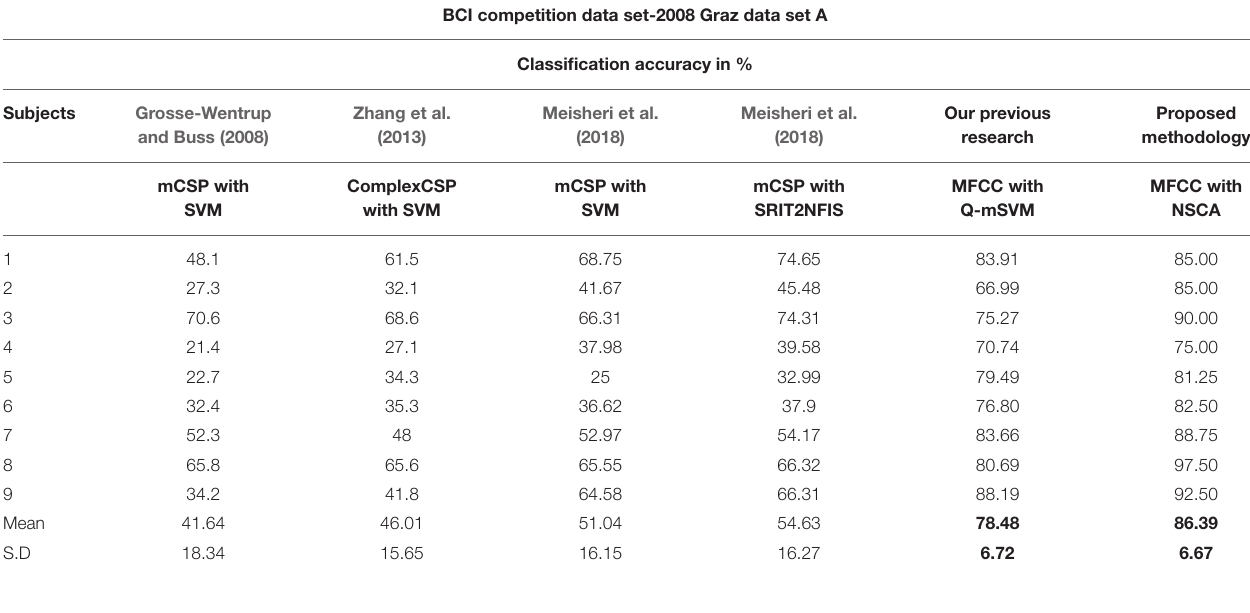
TABLE 6 | Classification accuracy of proposed approach as compared with other